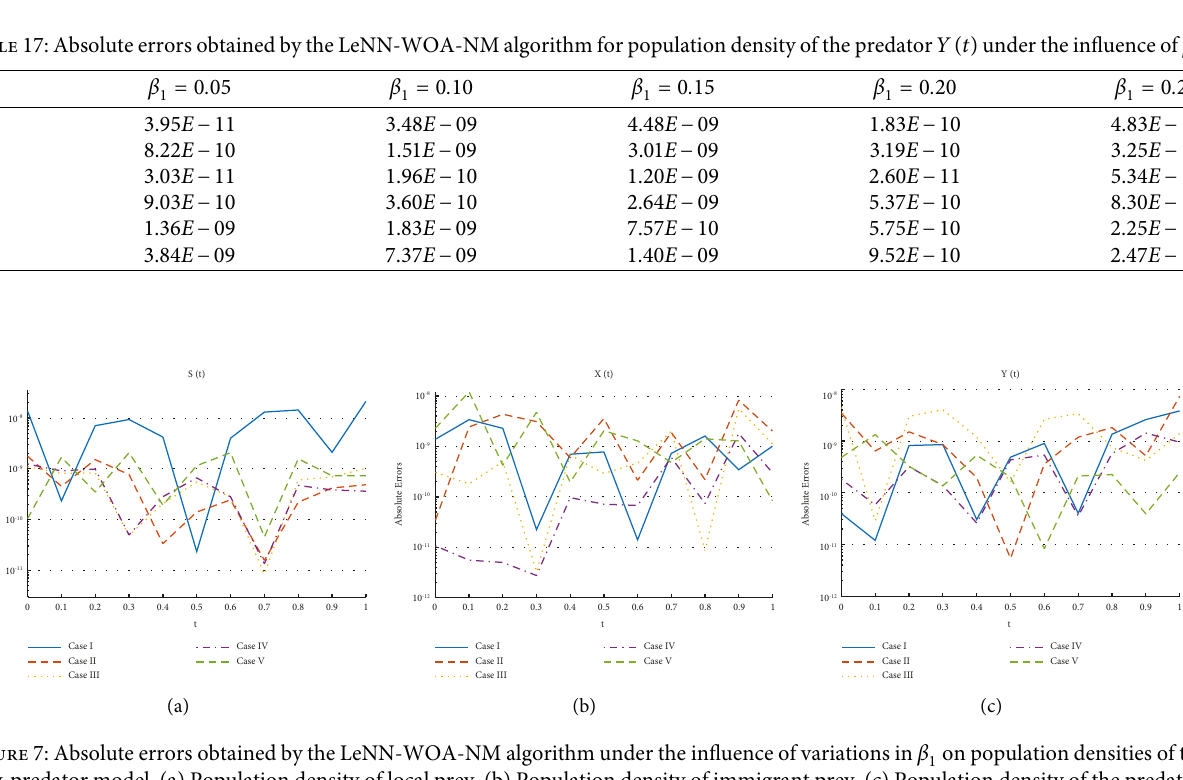
on population densities of the 1